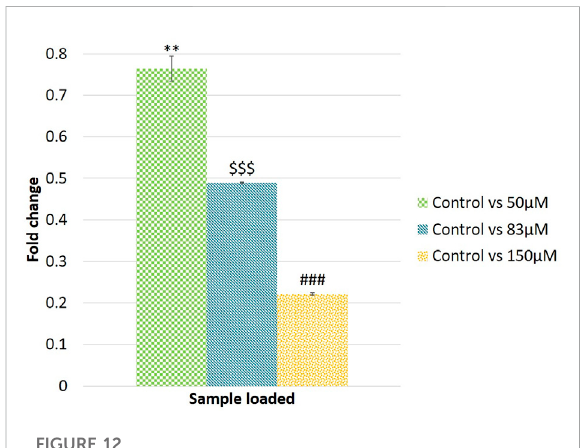
FIGURE 12 Validation of randomly selected known microRNAs by qRT- PCR. Log2 fold change of EGCG-MDAMB231-4. The signi fi cance of differences between control vs 50 µM EGCG indicated by “ * ” ; control vs. 83 µM EGCG indicated by “ $ ” ; control vs. 150 µM EGCG indicated by “ # ” . Signi fi cance levels of p < 0.005 ( “ *** ” ; “ $$$ ” ; “ ### ” ), p < 0.05 ( “ ** ” ; “ $$ ” ; “ ## ” ) are denoted. EGCG treatments were given for 24 h. Data are presented as mean ±